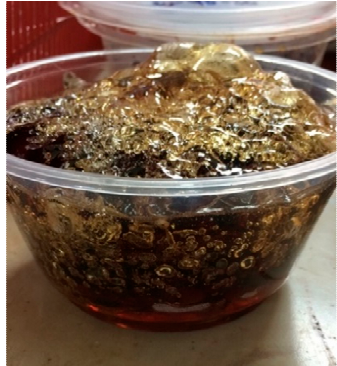
Figure 5. Sample of phenol formaldehyde (PF) resin prepared at 100 °C.